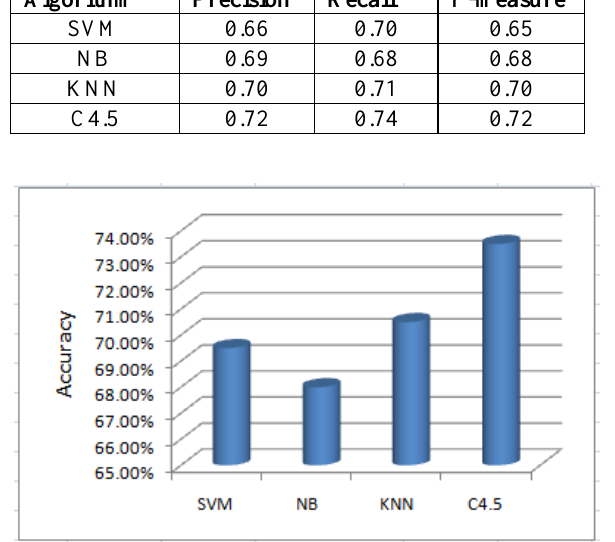
Figure 6. Accuracy Results of Various Machine Learning Techniques